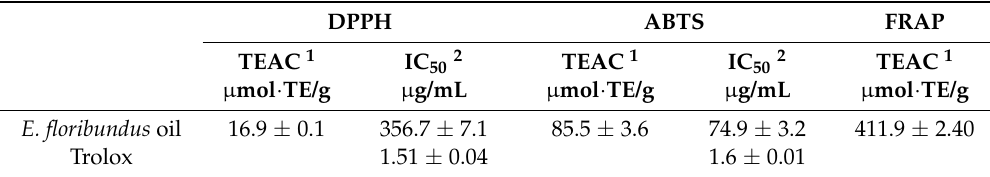
Table 4. Antioxidant activity of Erigeron floribundus essential oil.